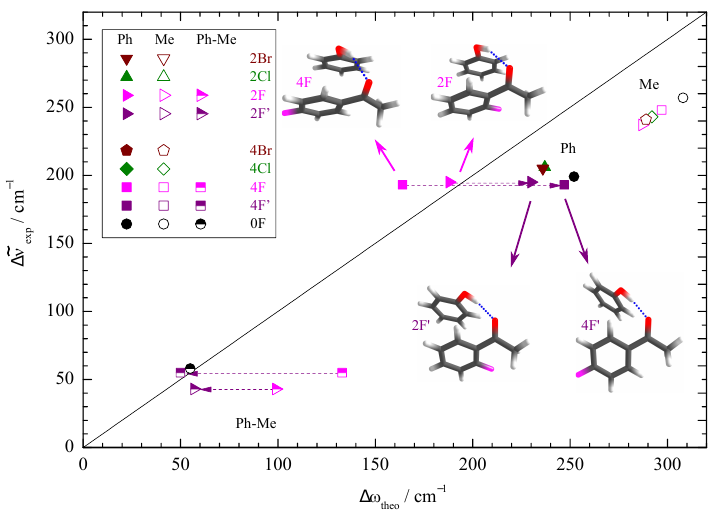
Figure 3. Correlation of the experimentally determined (anharmonic) OH complexation downshifts (Me, Ph) and splittings (Ph-Me) with their harmonic estimates predicted at B3LYP-D3/def2-TZVP level. The harmonic DFT shift overestimation, splitting prediction, and substitution trends are only uniform (symbol clustering) if the second-most stable Ph docking structures (2F’, 4F’) are assigned instead of 2F, 4F (dashed arrows).